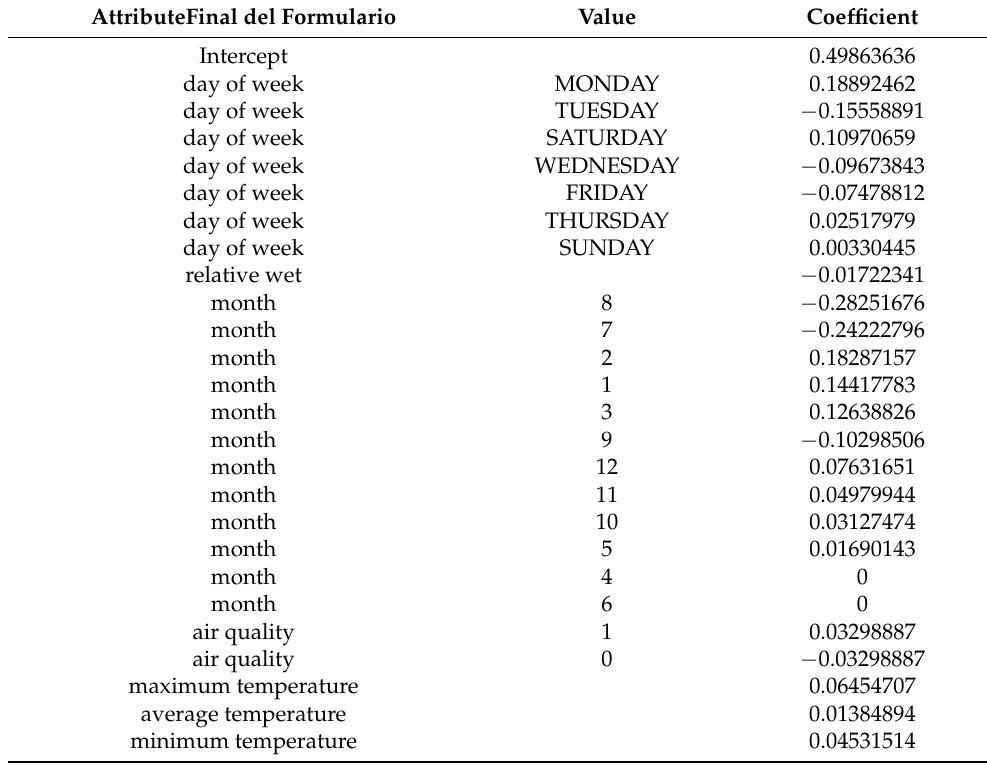
Table 7. Coefficient statistics for linear regression of the predictive